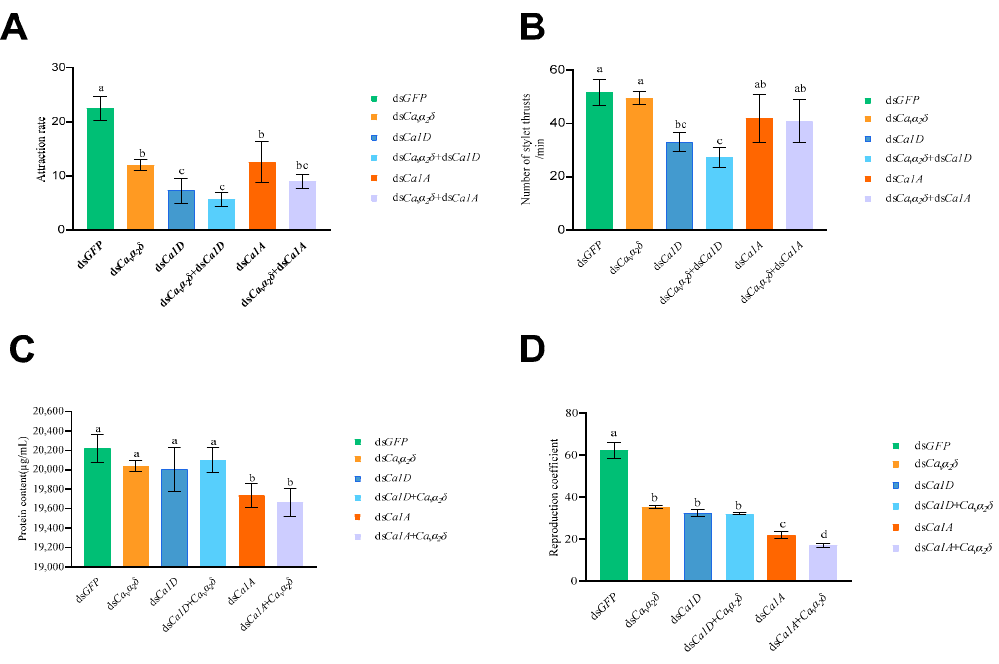
Figure 9. Effect of dsRNA soaking on the phenotype of D. destructor . ( A ) Effect of dsRNA soaking on the chemotaxis of D. destructor . ( B ) Effect of dsRNA soaking on the stylet thrusting of D. destructor . ( C ) Effect of dsRNA soaking on secreted proteins of D. destructor. ( D ) Effect of dsRNA soaking on the reproduction of D. destructor . The worms treated with clear water were set as the control. Different letters indicate significant differences at p < 0.05 by Duncan’s multiple range test. The experiments were performed three times with similar results.